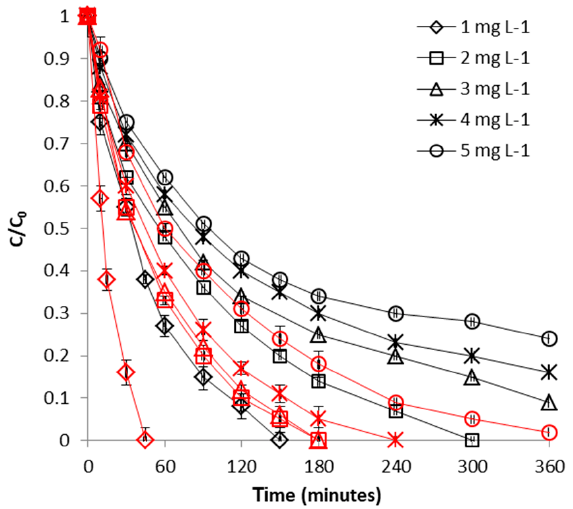
Figure 10. Effect of initial concentration on Cr VI removal by WSP-Fe 0 (red curves) and WSP (black curves). The lines are not fitting models; they simply connect points to facilitate visualization.